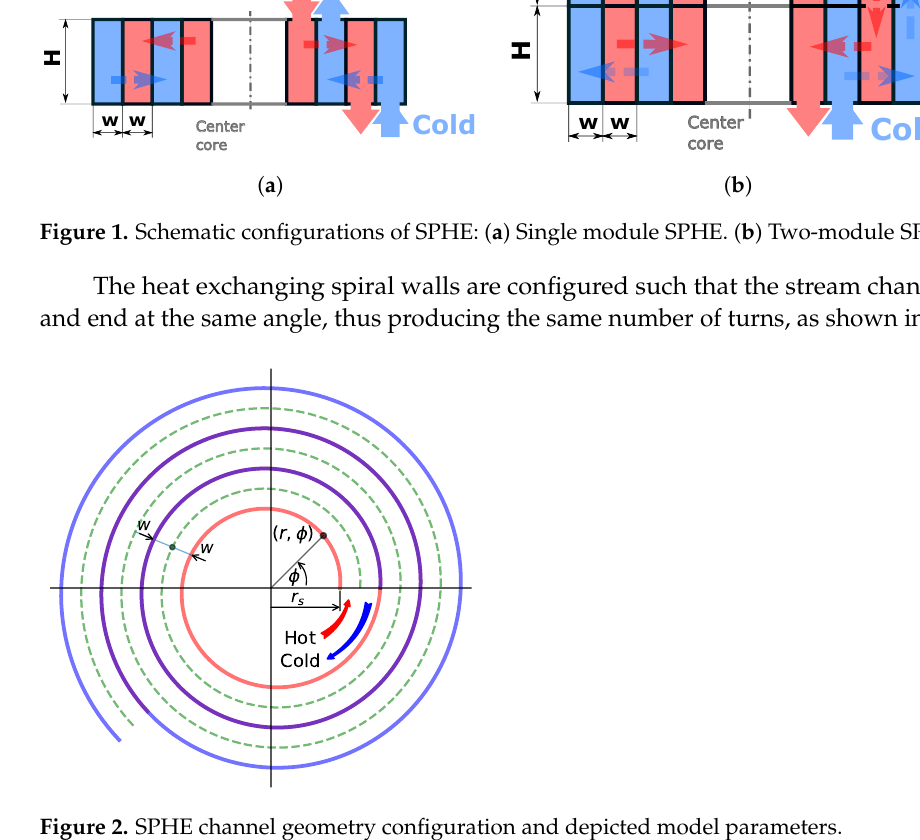
Figure 2. SPHE channel geometry configuration and depicted model